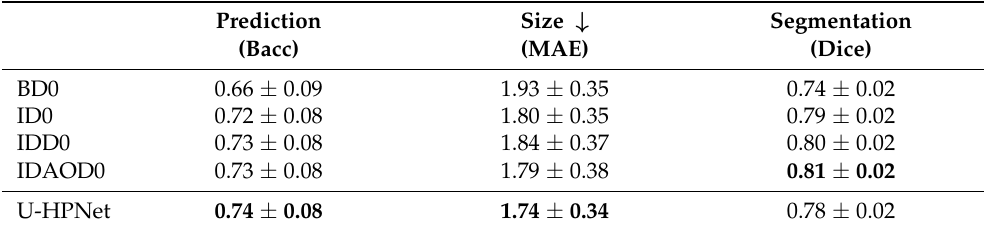
Table 4. Performance comparison between the different U-HPNet setups.